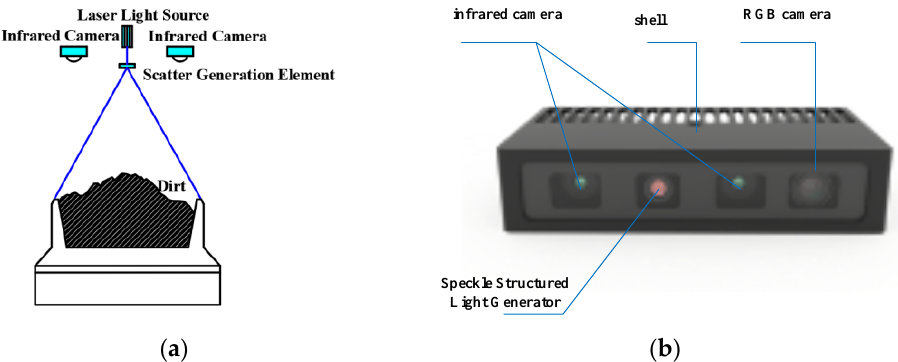
Figure 11. Data acquisition equipment: ( a ) Schematic diagram of equipment collection area; ( b ) Data acquisition equipment. ( b ) Data acquisition equipment.